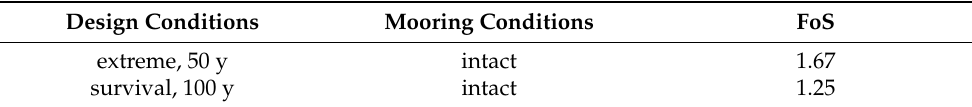
Table 5. Mooring buoy structure safety factors (Buoy-WEC platform connected).